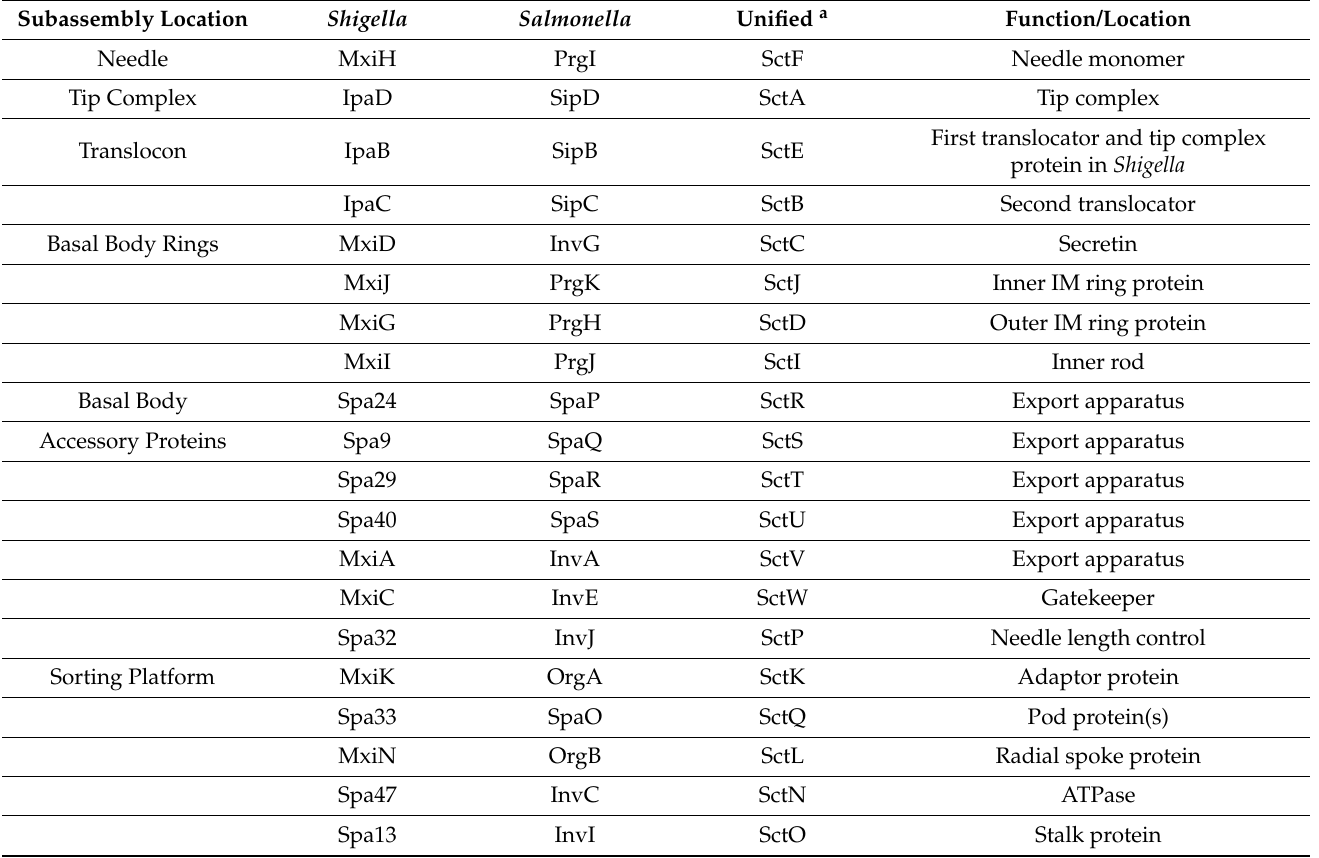
Table 1. Nomenclature for the Shigella Type III Secretion System